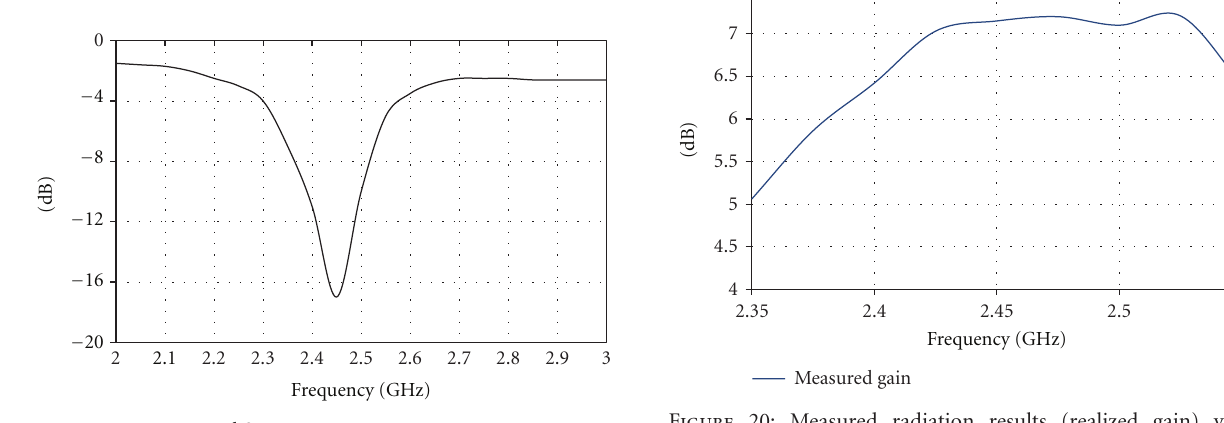
Figure 20: Measured radiation results (realized gain) versus frequency of the dual-beam printed dipole